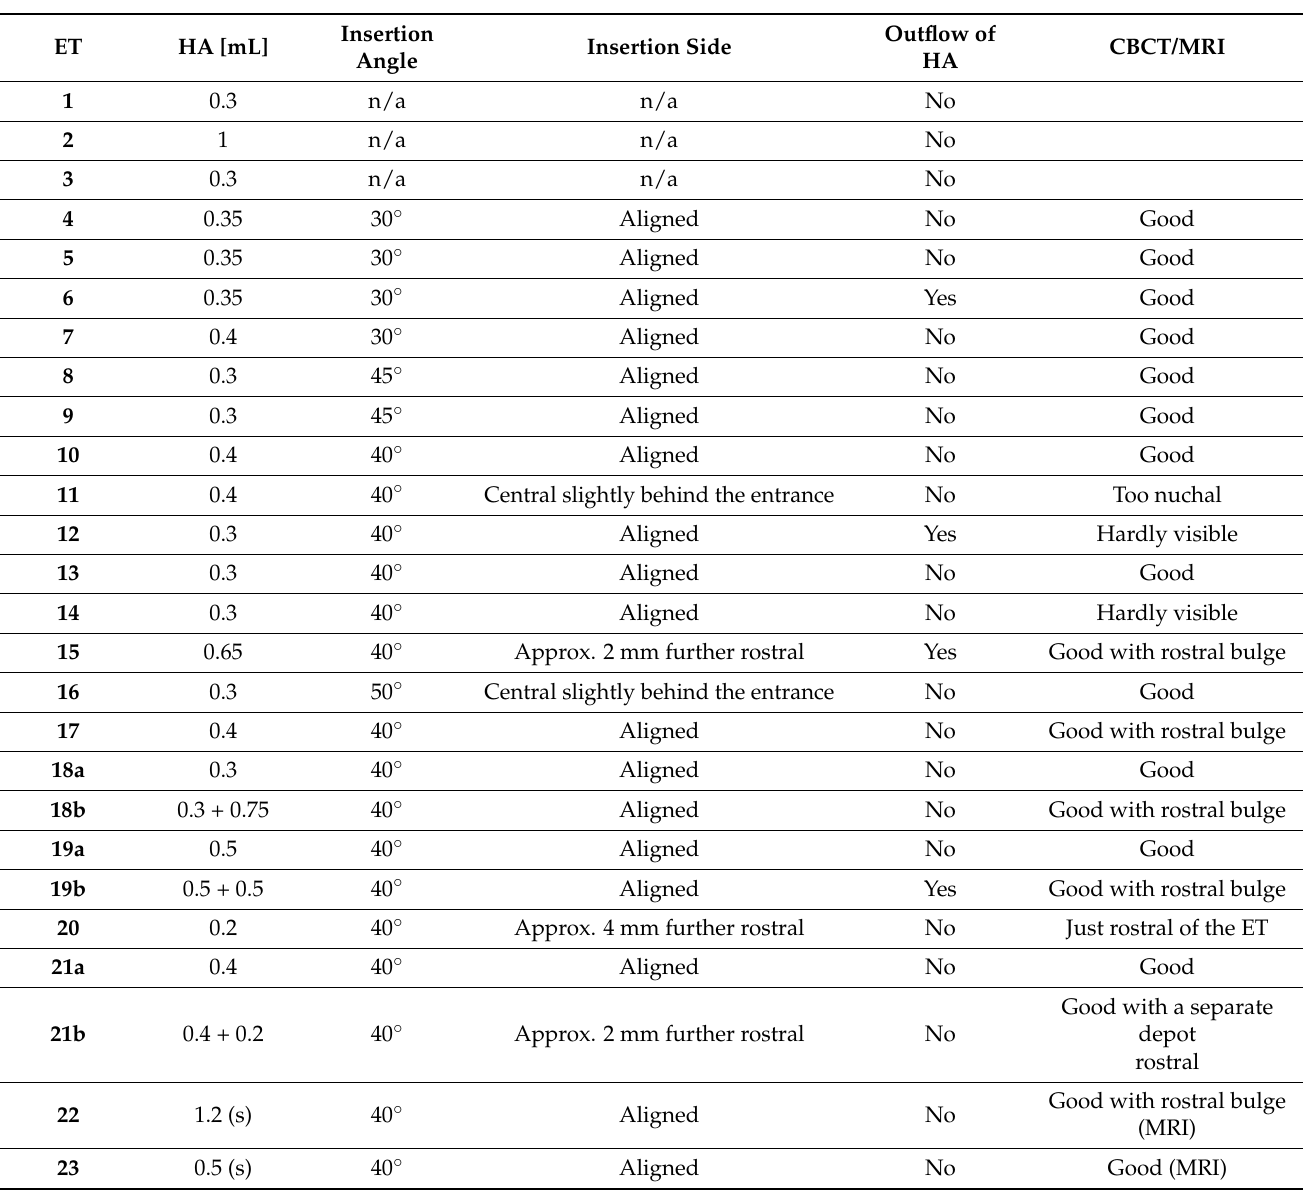
Table 1. Results of the ex vivo